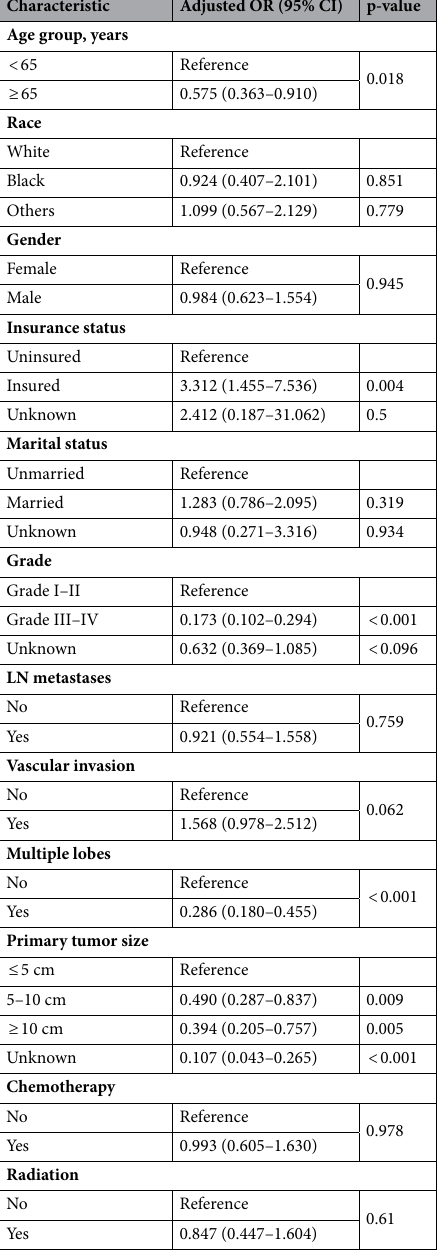
Table 2. Logistic regression model for receiving